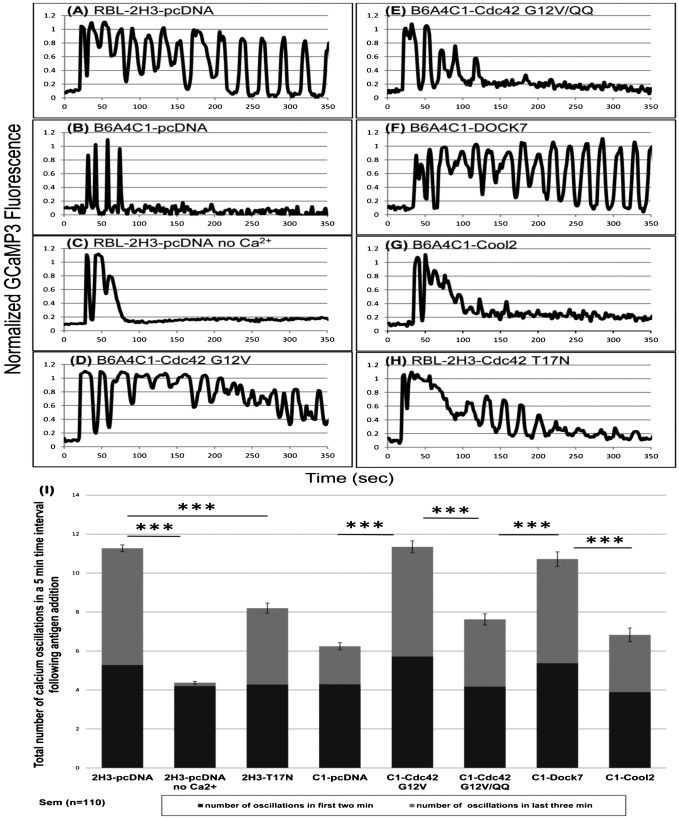
Activation of Cdc42 by antigen is necessary for sustained Ca2+ oscillations in RBL mast cells.RBL-2H3 mast cells were co-transfected with GCaMP3 and pcDNA (A,C) or dominant negative Cdc42 T17N (H). B6A4C1 cells were co-transfected with GCaMP3 and pcDNA (B), Cdc42 G12V (D), Cdc42 G12V/QQ (E), the Rho family GEFs DOCK7 (F) or Cool2 (G). Ag (0.2 µg/ml) was added at t = 0, and representative examples of Ca2+ responses are shown. (I) Summary of quantification of Ca2+ oscillations stimulated by 0.2 µg/ml multivalent DNP-BSA. Dark grey histograms are the number of oscillations occurring in the first two minutes following the initial Ca2+ spike, and light grey segments are the number of oscillations that occur in the last three minutes of the five minute stimulation time period. 2H3: RBL-2H3 cells; C1: B6A4C1 cells. Error bars refer to the total five minute responses and indicate ±s.e.m. for 110 individual cells for each condition shown (***P<0.001).